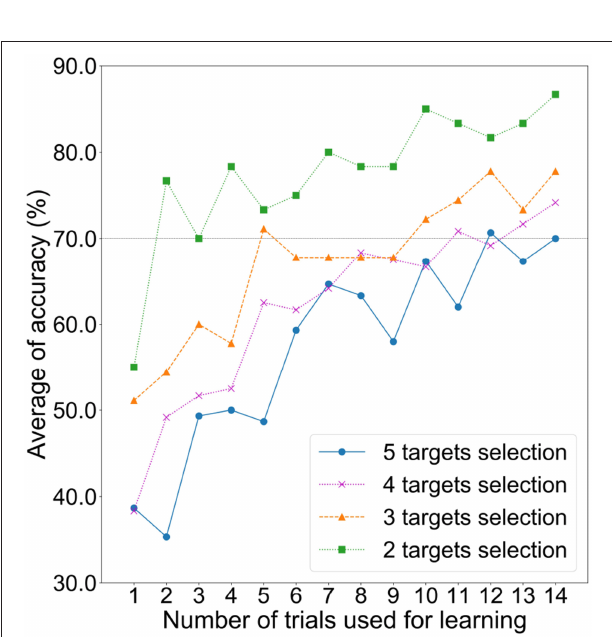
paradigm maintained a high level of accuracy without using any vertex